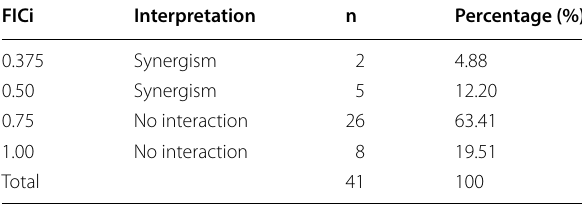
Table 3 Inhibition zone diameters (mm) of the